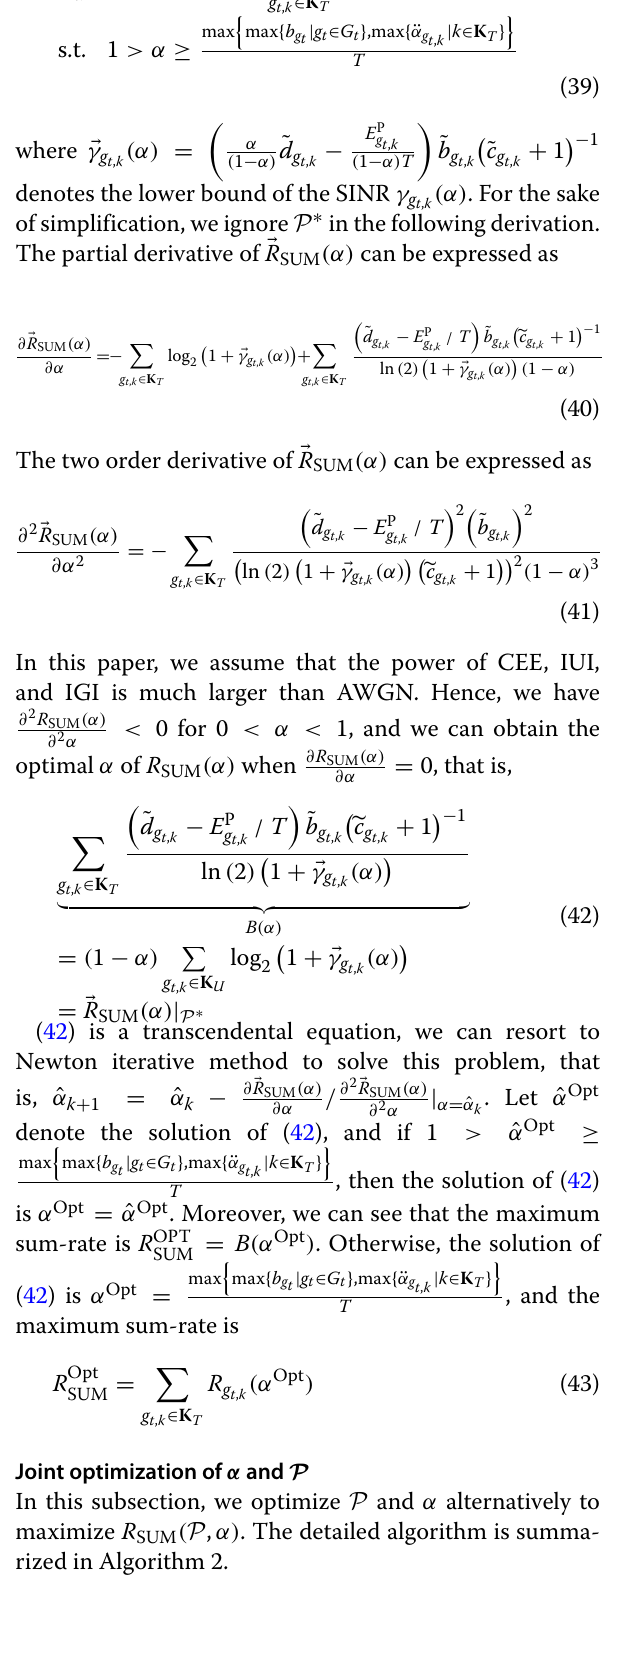
Algorithm 1 Solving problem (33) by